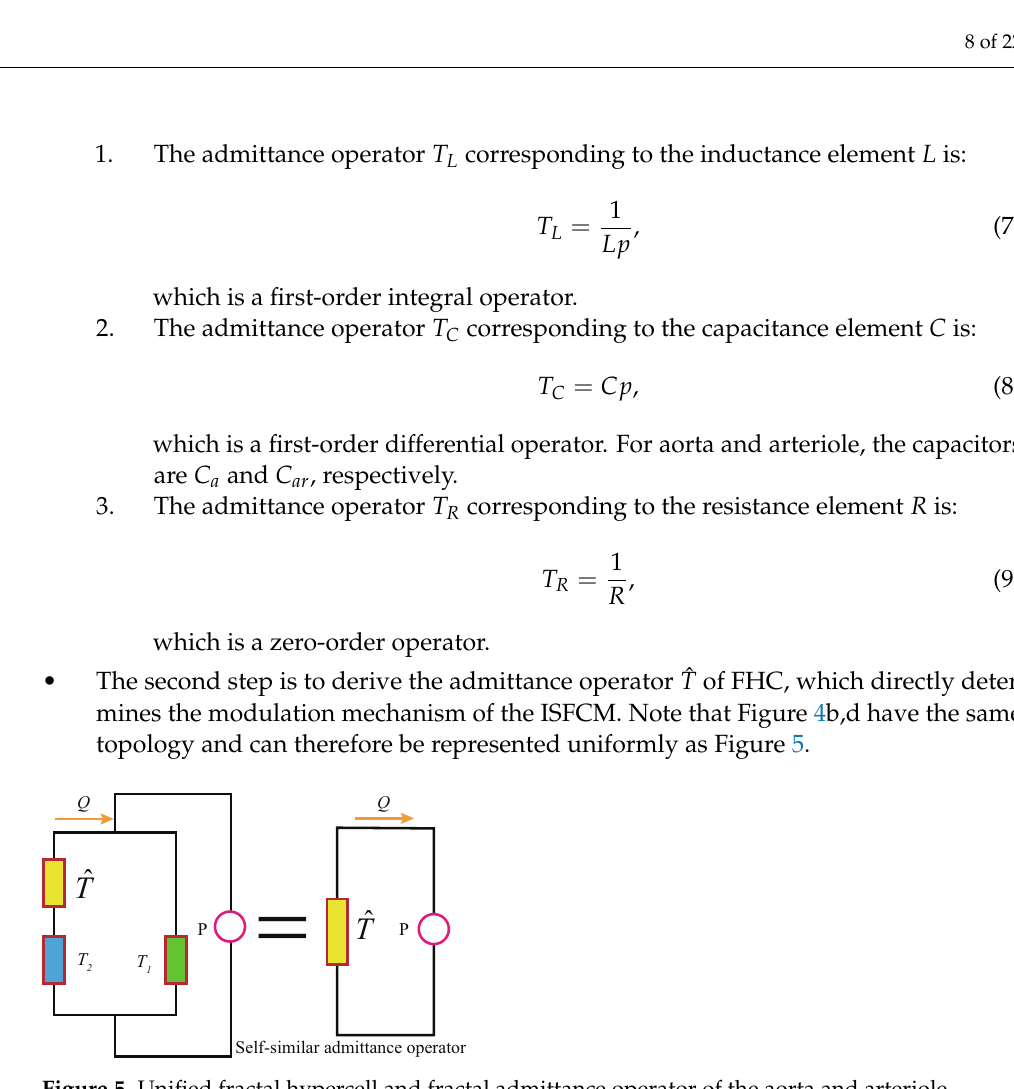
Figure 5. Unified fractal hypercell and fractal admittance operator of the aorta and